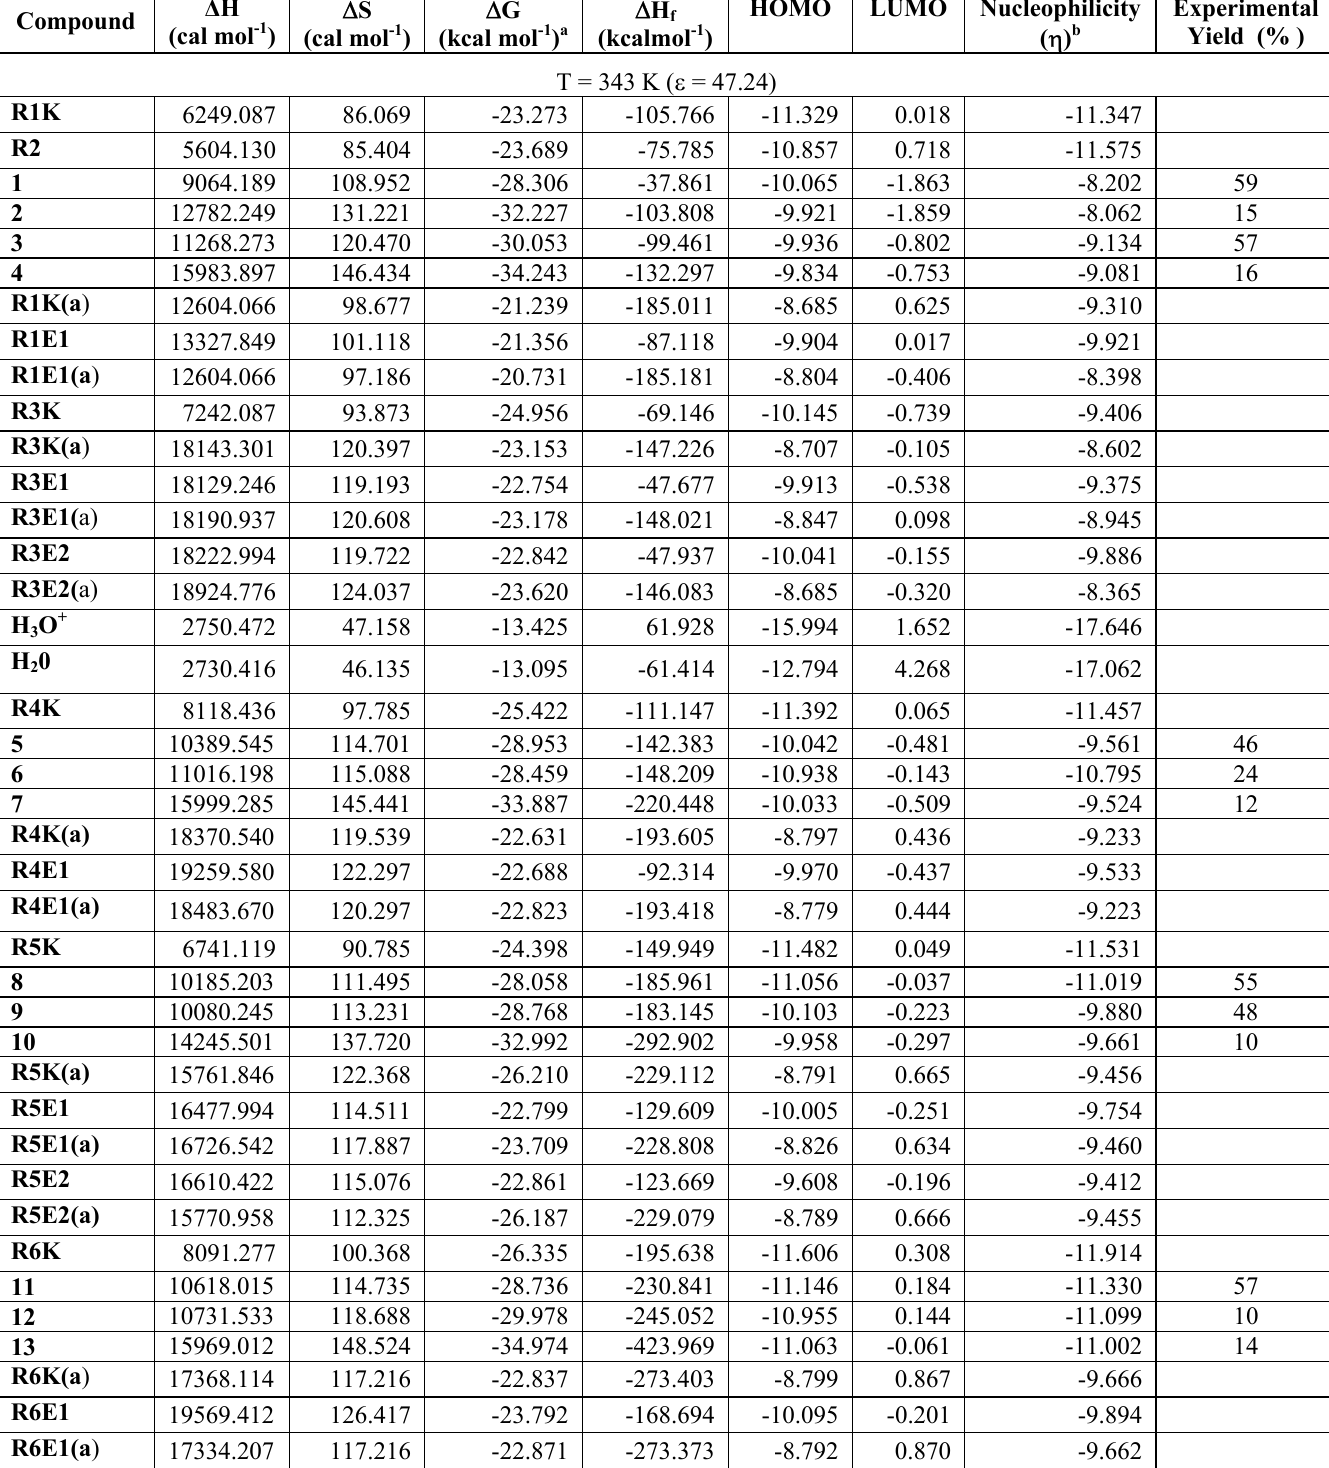
Table 1 . Liquid phase PM3 calculated physical parameters of the studied